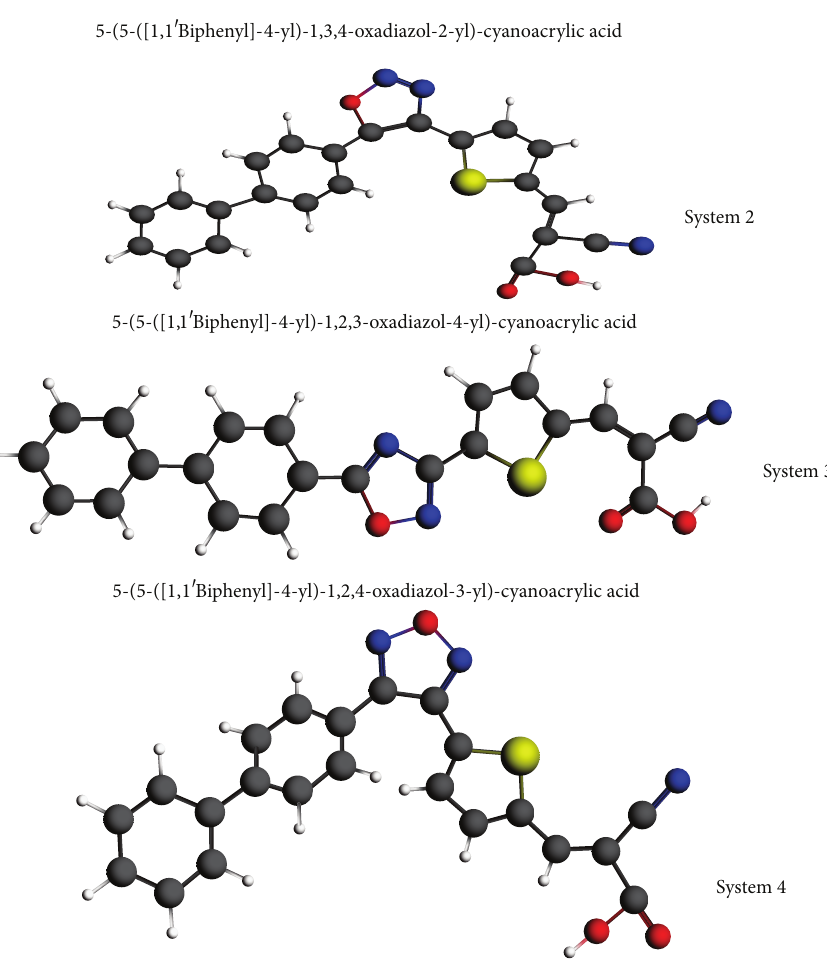
Figure 1: Chemical structures of organic